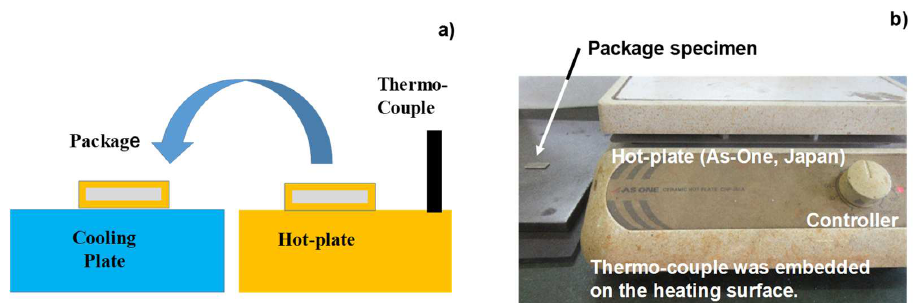
Figure 5. Thermal transient loading test. ( a ) A schematic view of the thermal transient loading, and ( b ) the experimental setup for this thermal transient loading test.